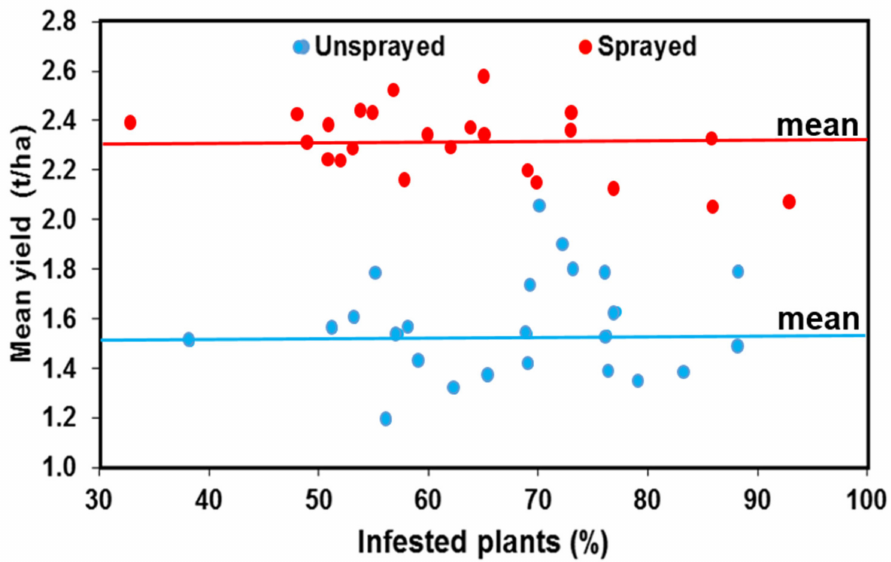
Figure 3. A scatterplot indicating the incidence (%) of infested plants and yield per hectare of unprotected and protected plants in field trial 4 under natural infestation by Spodoptera frugiperda . Sprayed treatments imply insecticide applications to each plot at 4, 5, 6 and 7 WAE. Bars represent standard errors.